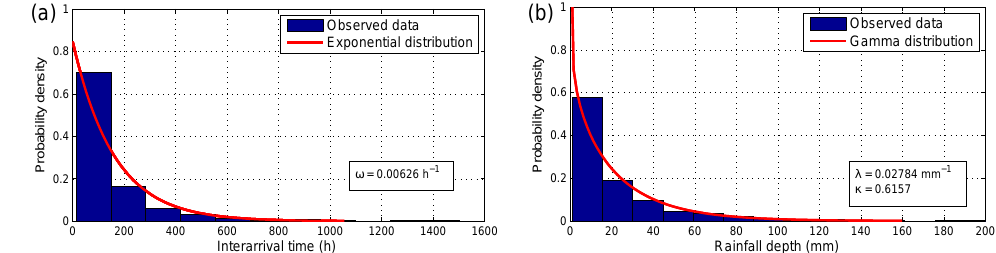
Figure 2. Fitted distributions to inter-arrival times (a) and rainfall depths (b) for 25 years of data in